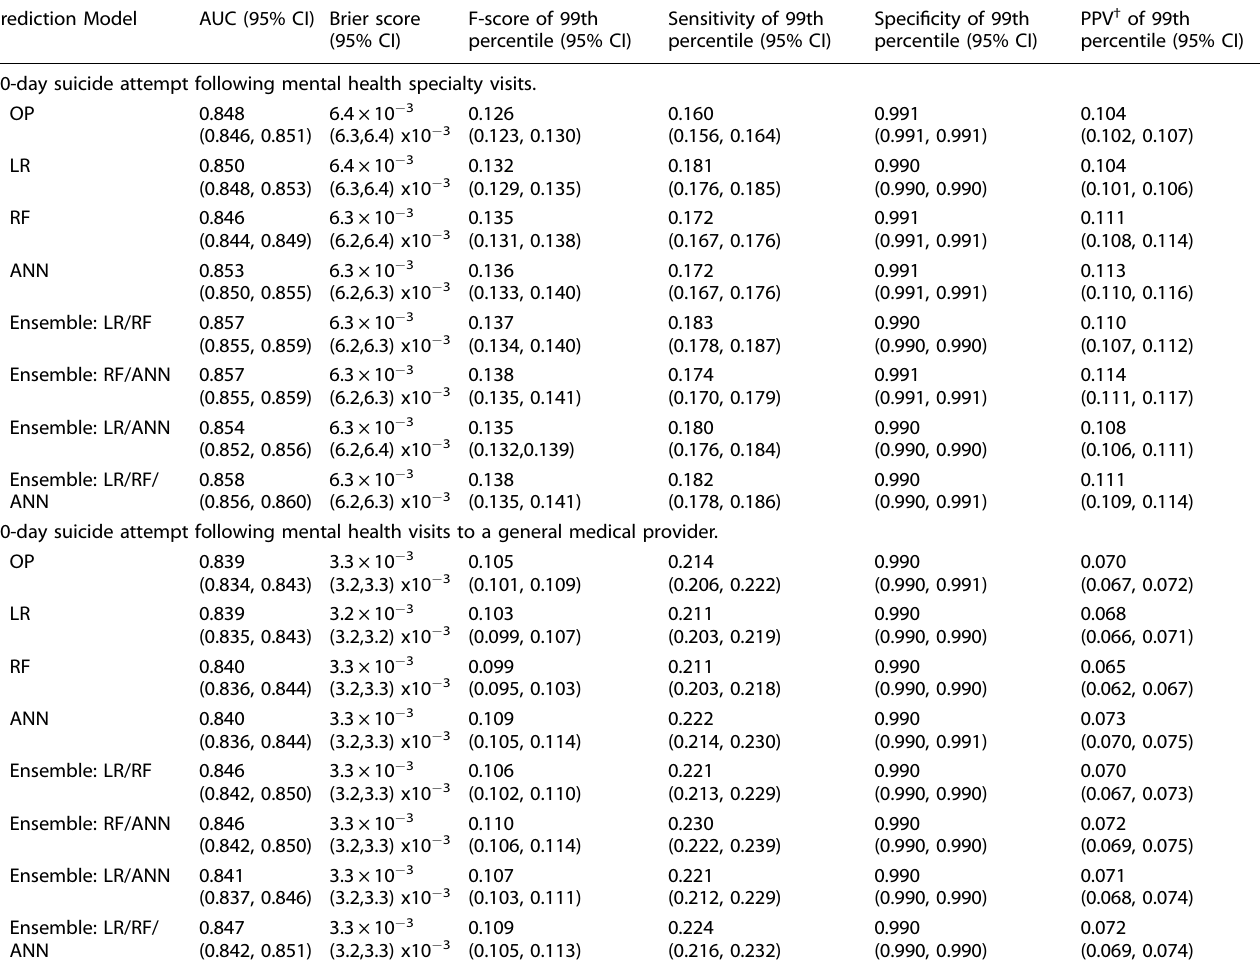
Table 3. Prediction performance in entire validation data for suicide attempt in the 90 days following an outpatient visit; 95% con fi dence intervals (CIs) constructed using 10,000 bootstrap samples.